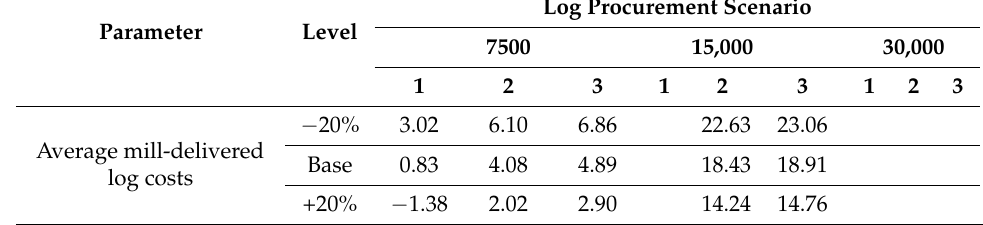
Table A2. Sensitivity of NPV of two-stage LVL manufacture to changes in levels of several important model parameters at facility location